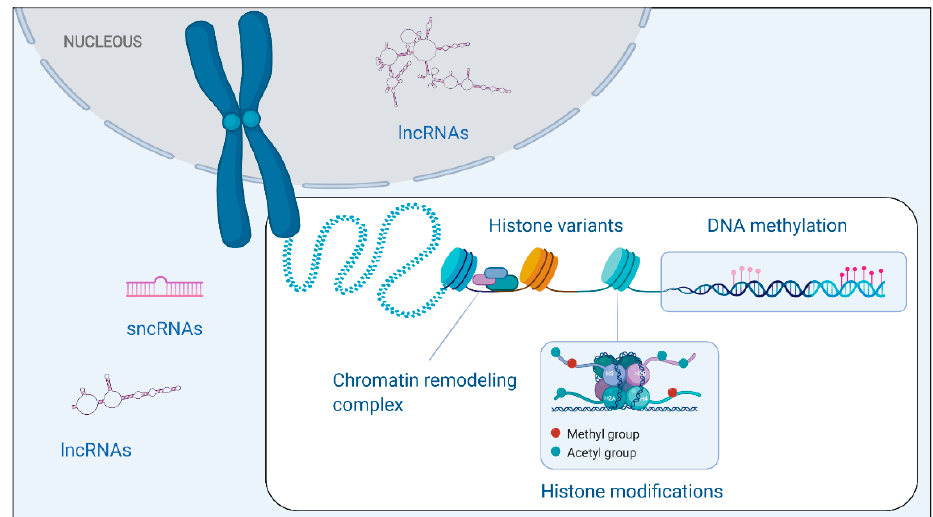
Figure 1. Schematic representation of epigenetic machinery components. DNA methylation is catalyzed by DNA methyl transferases (DNMT) and consists of covalent addition of a methyl group to the 5-carbon of the cytosine ring resulting in 5-methylcytosine (5-mC). Histone post-transcriptional modifications constitute another type of epigenetic-based gene regulatory mechanism. These reactions (e.g., acetylation and methylation) occur in the residues of histone tails and are extremely refined, being catalyzed by highly regulated enzymes. In addition, histones might also have variants, which alter nucleosome functionality. Chromatin remodeling complexes, such as SWItch/Sucrose Non-Fermentable (SWI/SNF), Imitation SWI (ISWI), INO80, and Nucleosome Remodeling Deacetylase (NuRD), alter chromatin architecture, through direct interaction with nucleosomes. Finally, non-coding RNAs, namely small non-coding RNAs (sncRNAs) and long non-coding RNAs (lncRNAs) post-transcriptionally regulate gene expression, both in the nucleus and cytoplasm. Created by BioRender.com (https://biorender.com/)